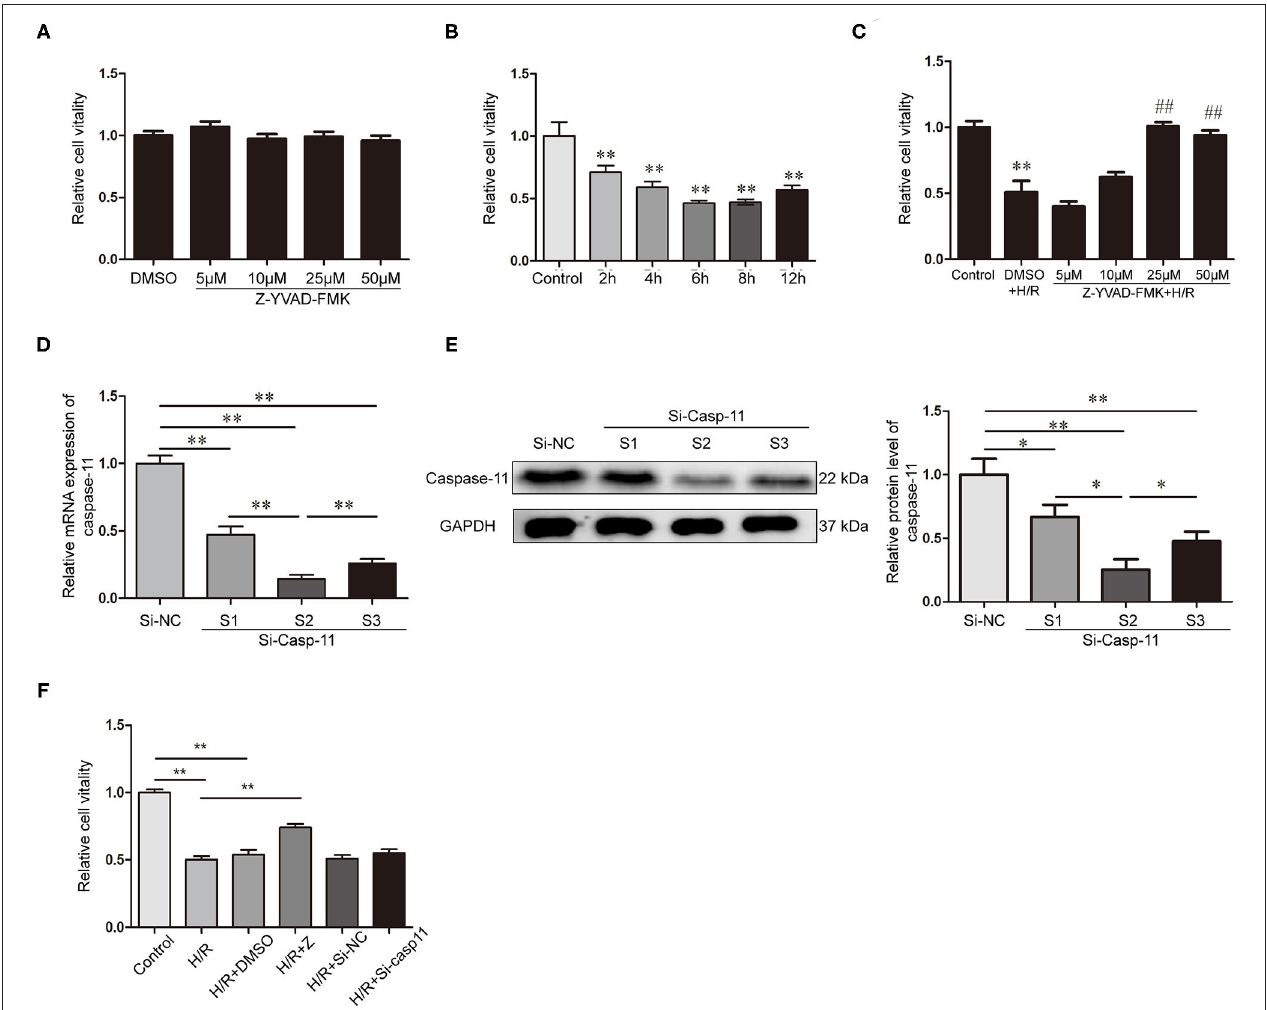
FIGURE 5 | Decreasing of caspase-1 and caspase-11 affect the cell activity of NRK-52E cells after H/R. (A) Effects of different concentrations of Z-YVAD-FMK on cell activity in normoxic state. (B) NRK-52E cell activity at different times of reoxygenation. (C) Effects of different concentrations of Z-YVAD-FMK on the cell activity after 6h of H/R. (D) Expression of caspase-11 mRNA after caspase-11 siRNA transfection. (E) Expression of caspase-11 protein and statistical analysis after caspase-11 siRNA transfection. (F) Effect of caspase-1 inhibition by Z-YVAD-FMK and caspase-11 inhibition by siRNA on cell activity, as detected by CCK-8. * p < 0.05, ** p < 0.01, ## p < 0.05. Z = Z-YVAD-FMK; H/R, hypoxia/reoxygenation; R, reoxygenation; DMSO, dimethyl sulfoxide; Si-casp11, small interfering ribonucleic acid caspase-11; Si-NC, si-caspase-11 negative control; GAPDH, glyceraldehyde-phosphate